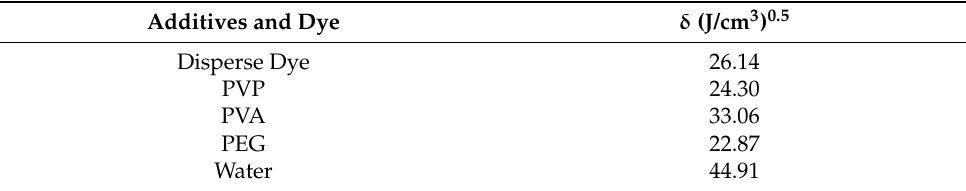
Table 2. Solubility parameters ( δ ) of the disperse dyes and